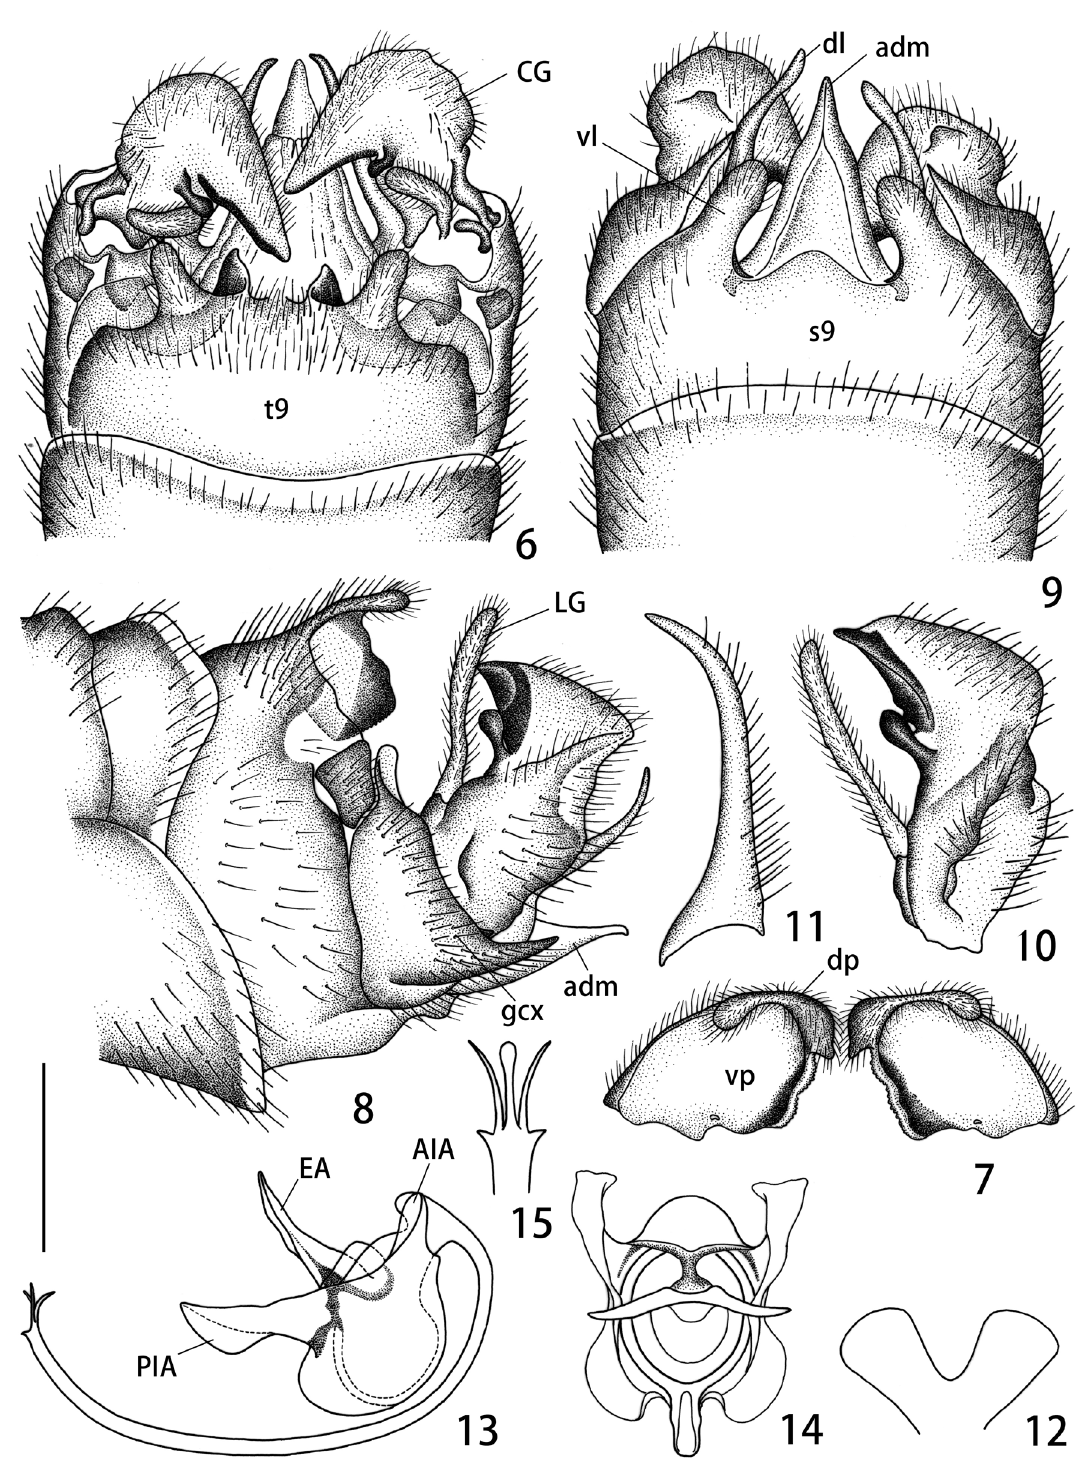
Figs 6–15. Tipula ( Vestiplex ) cibagouensis sp. nov., ♂ , holotype (coll. Inse-XZ3768). 6 . Hypopygium, dorsal view. 7 . Tergite nine, ventral view. 8 . Hypopygium, lateral view. 9 . Hypopygium, ventral view. 10 . Left lobe and clasper of gonostylus, lateral view. 11 . Dorsal lobe of A9S. 12 . Ejaculatory apodeme of semen pump. 13 . Semen pump, lateral view. 14 . Semen pump, dorsal view. 15 . Apex of aedeagus. Abbreviations: see Material and methods. Scale bars: 6–11 = 0.5 mm; 12–14 = 0.6 mm; 15 =